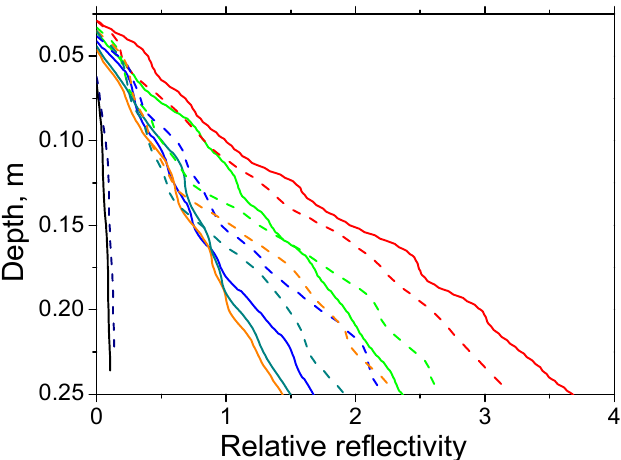
Figure 10. Relative reflectivity of sand f ( h ) for experiment 1 (sand sample No. 1, solid lines) and experiment 2 (sand sample No. 2, dashed lines) for different drainage times indicated by the line colors: black color—naturally dry sand; red color—immediately after moistening; green blue, brown, and dark-blue colors—after 0.5, 3.5, 24, and 48 h of water drainage. Moistening the samples No. 1 and 2 with water in a volume of 15.1 L leads to an increase in the amplitude of the reflected wave in areas with a nonzero gradient of the refractive index (Equation (4)) and related growth of f ( h k ) . This leads to an increase in the slope of the dependences f ( h ) reaching maximum immediately after the sand layer is moistened (red lines in Figure 10). As the drainage proceeds, the moisture content of the upper layers decreases. This causes a decrease in f ( h ) and the tangent of the angle to the depth axis. As follows from Table 1, the filtration coefficient for sample No. 1 is greater than that for sample No. 2; this explains the faster decrease in the slope of the graphs of relative reflectivity of sample